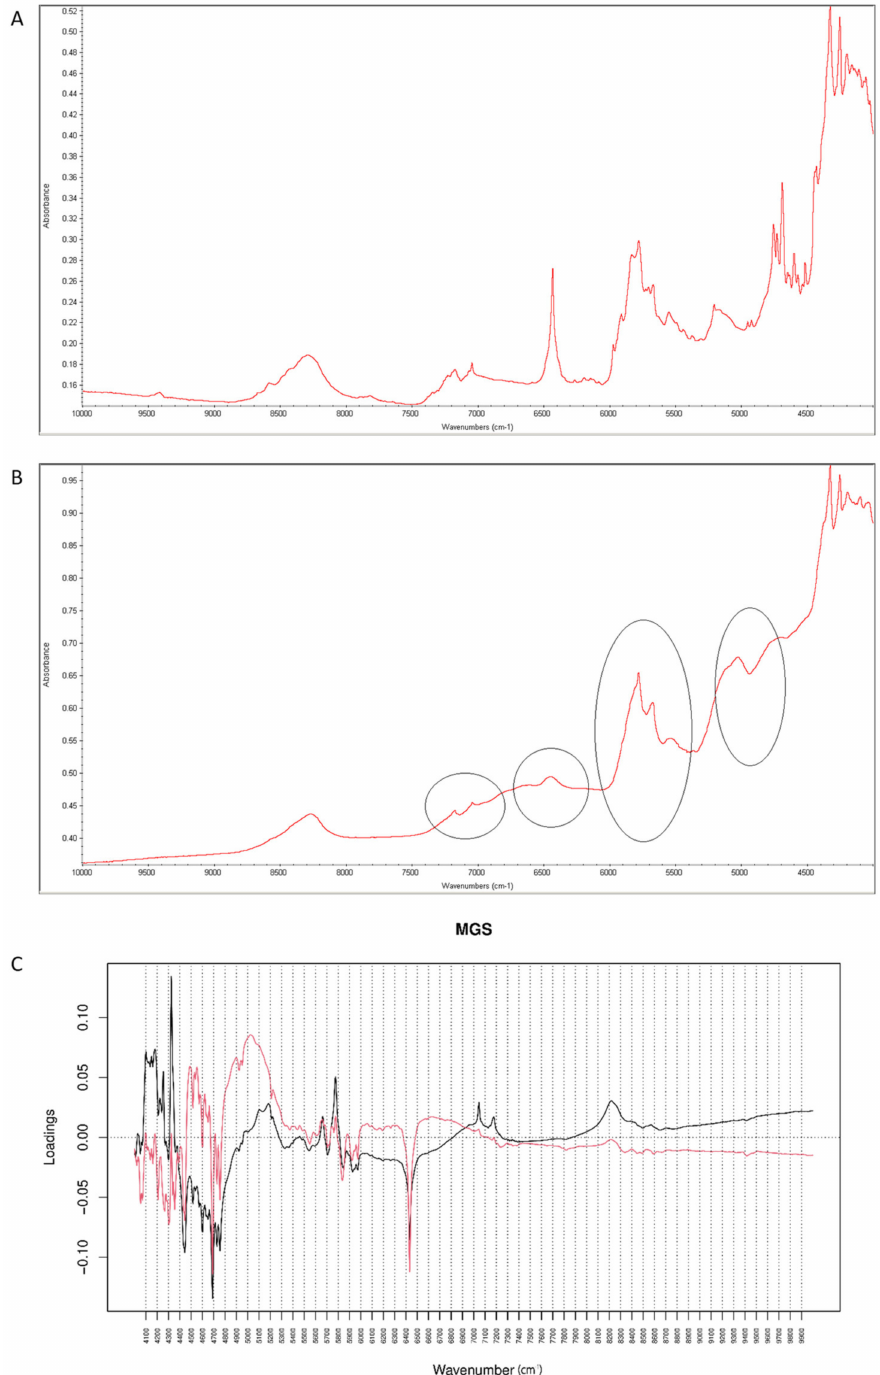
Figure 17. ( A – C ) Vildagliptin and magnesium stearate (MGS): NIR spectra of no stressed mixture ( A ), stressed mixture ( B ) and PCA loadings of the spectra ( C ); PC1 loadings are marked black while PC2 loadings are marked red; most visible differences in the spectrum of the stressed mixture are indicated with